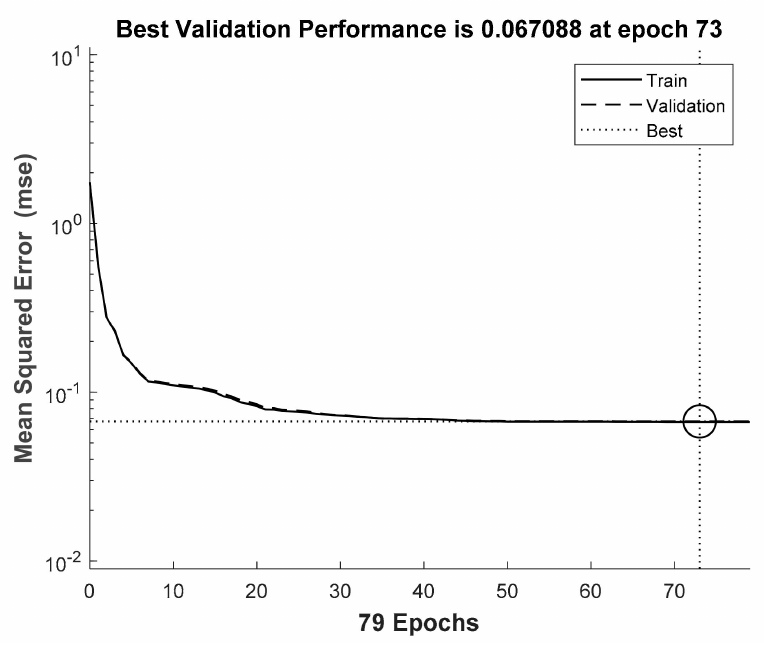
Figure 8. Learning curve of the network with three hidden layers.